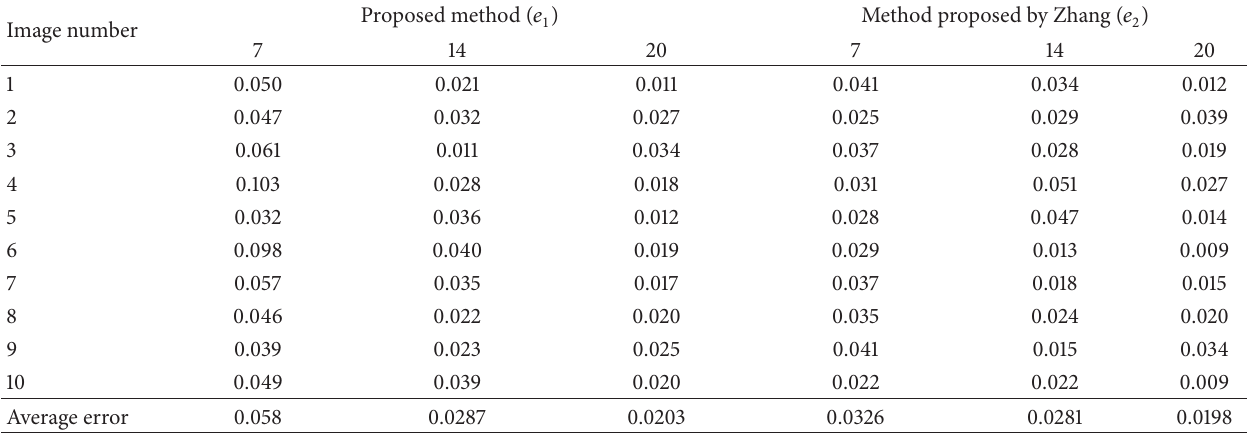
Table 1: Calibration error (mm).